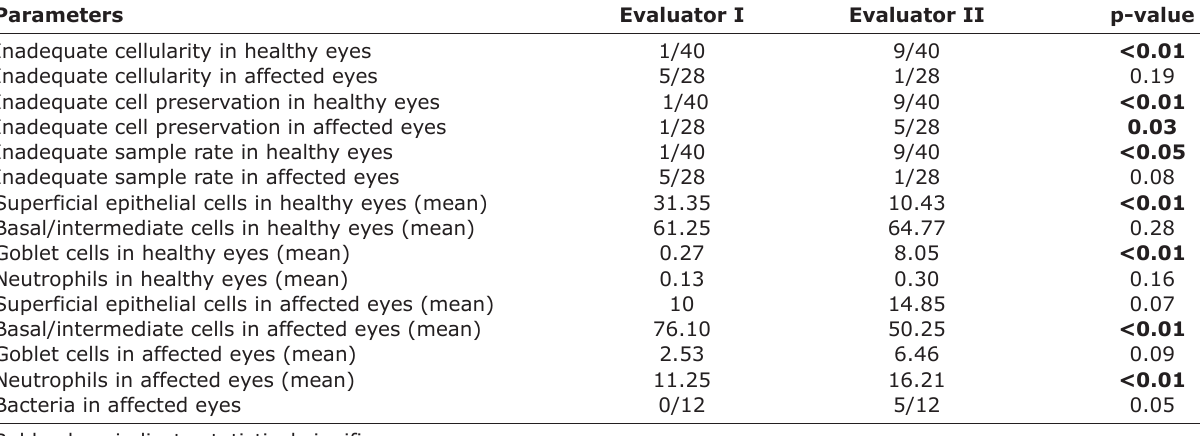
Table-3: Parameters evaluated by two variably experienced evaluators. Parameters